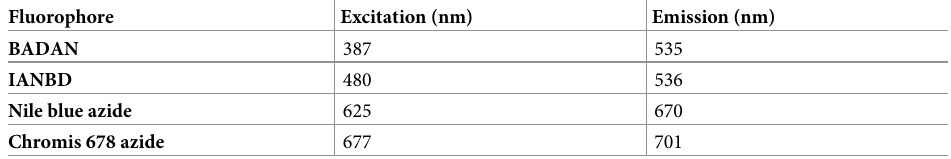
Table 2. Fluorophores attached to glucose binding protein mutants and their respective excitation and emission